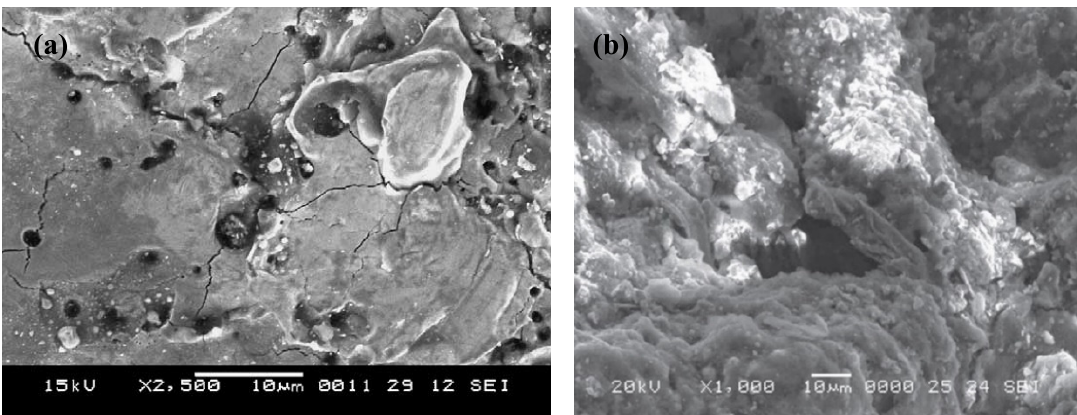
Figure 19. ( a ) Formation of microcracks and ( b ) crack and crater on cemented carbide coatings following an EDM process [124,128]. Reprinted with permission from [124,128]; 2018, 2003